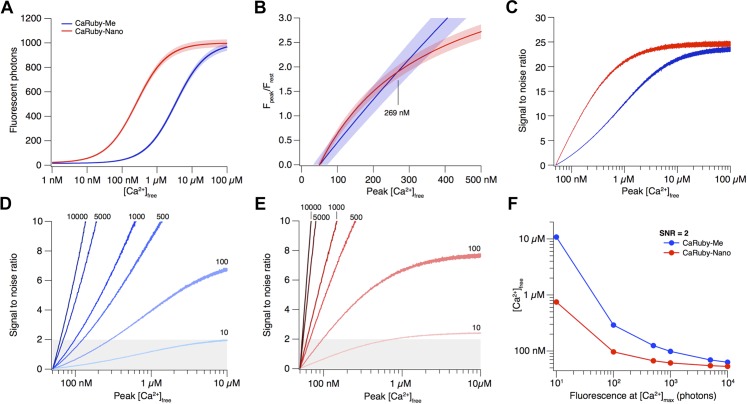
Signal amplitude and SNR depend on indicator KD.(A) [Ca2+]-dependent fluorescence for CaRuby-Me (blue) and CaRuby-Nano (red). The theoretical noise levels (1 SD) are indicated by the translucent areas. (B) [Ca2+]-dependent dF/F0 for both indicators (same colors as in a) with the uncertainties indicated by the areas surrounding the curves. (C) [Ca2+]-dependent SNR (same color code as in A). Note that the noise on the curves is a consequence of the Monte-Carlo simulations. (D) SNR curves for CaRuby-Me at different maximum fluorescence levels (maximal photon numbers indicated next to the corresponding curves). The grey area marks the area with SNR < 2. (E) SNR curves for CaRuby-Nano at the same brightness levels as in d. (F) [Ca2+]peak required to reach SNR = 2 for different maximal brightness levels.